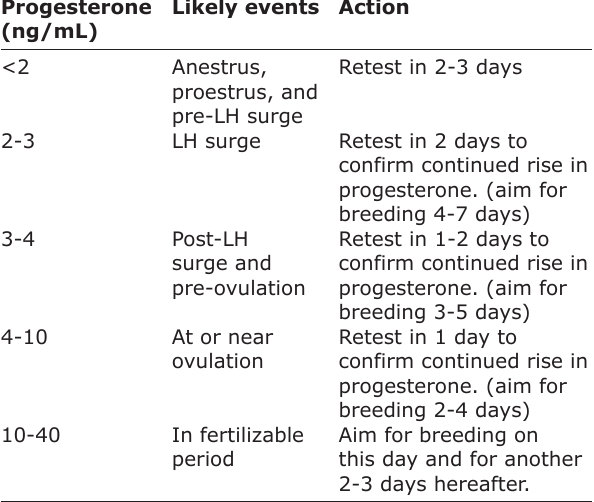
Table-2: Reference or guideline for progesterone interpretation using RFICA in heat or apparent reproductively quiescent bitches. Progesterone